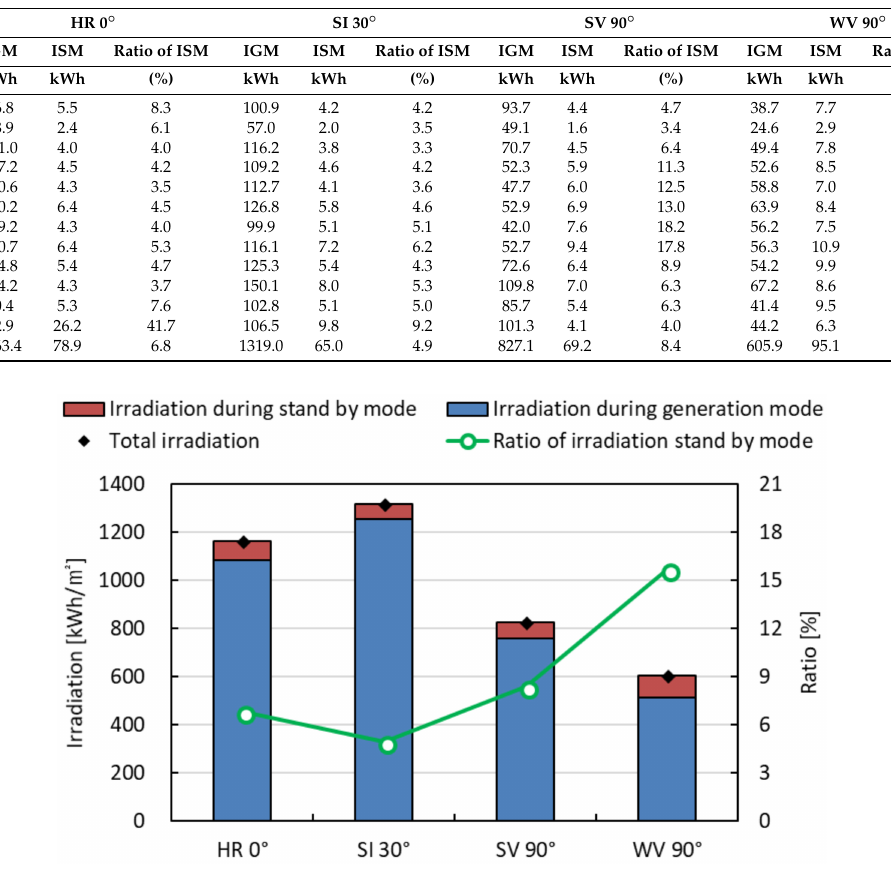
Figure 12. Analysis result of irradiation during standby mode and generation mode of each array.